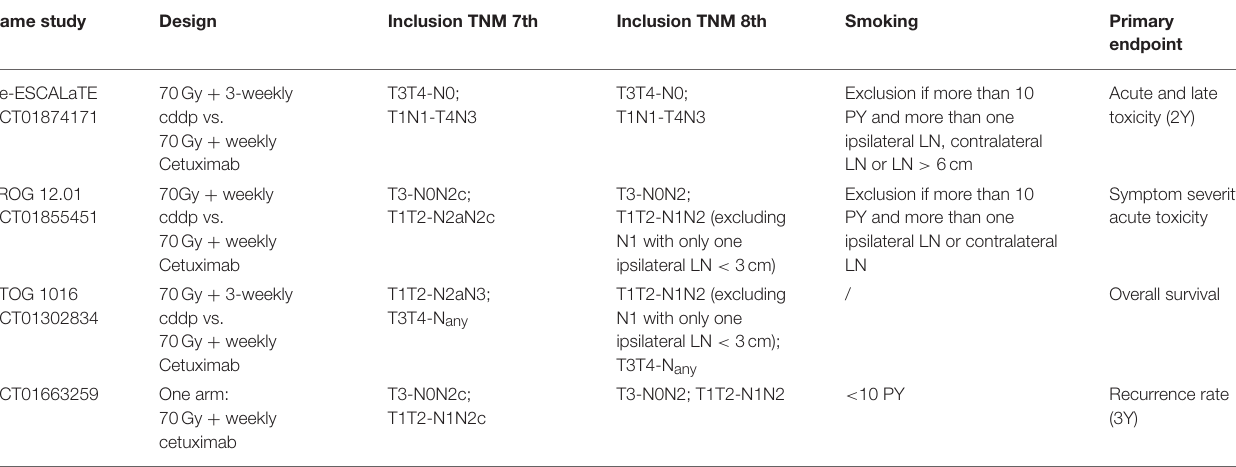
TABLE 2 | De-intensification trials replacing cisplatin by